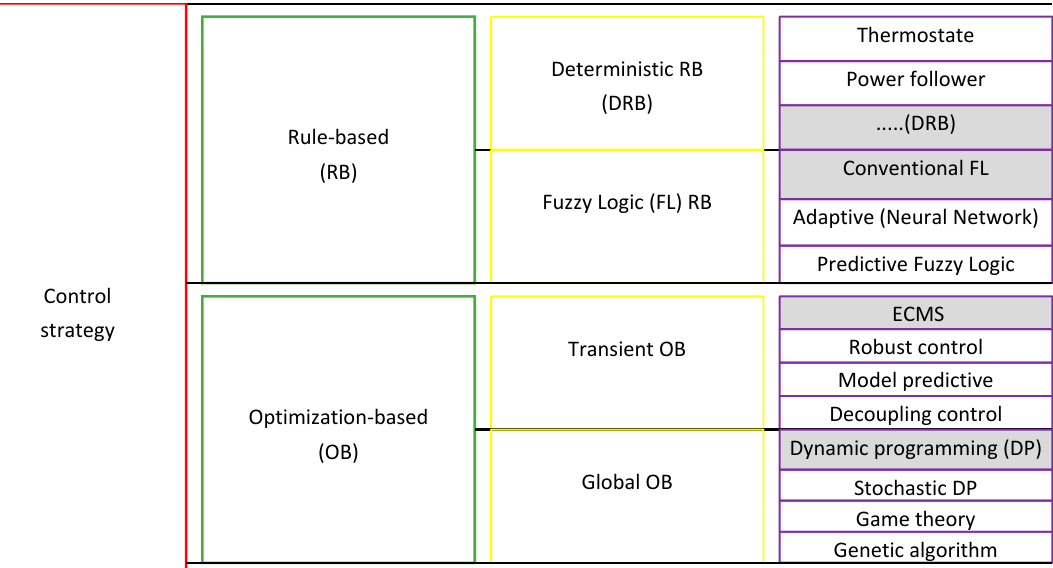
strategy. strategy.